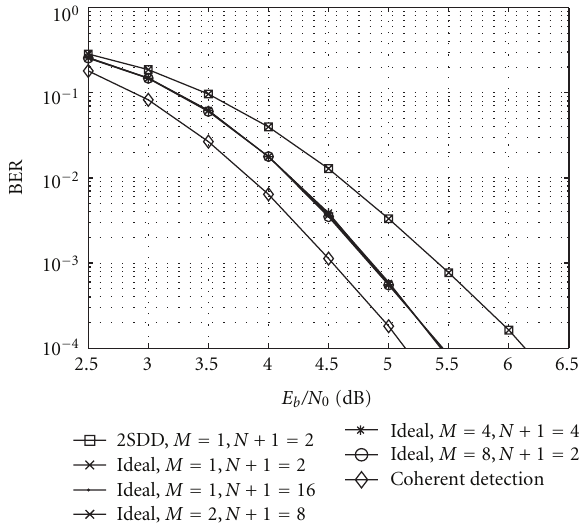
Figure 7: Bit-error performance with ideal LLRs for a decomposed multi-carrier trellis for di ff erent values of M and N but with a fixed block-size of M ( N + 1) =